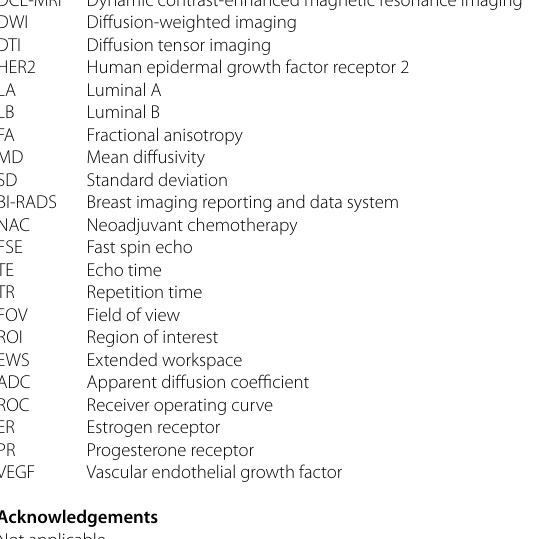
*means that the P value is significant